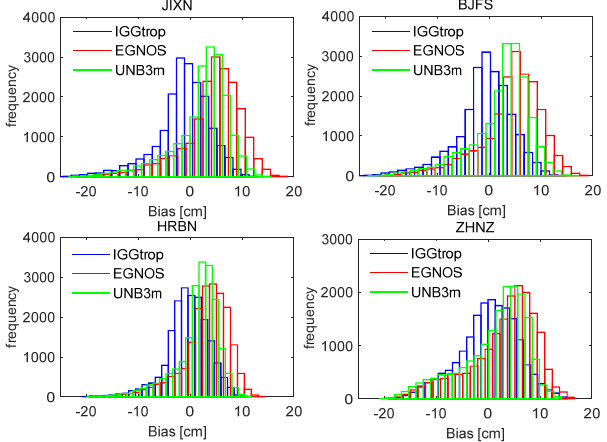
Figure 3. Histogram of the biases for the IGGtrop, EGNOS and UNB3m models over the period from 2009 to 2013 at four exemplary stations of JIXN, BJFS, HRBN and ZHNZ.